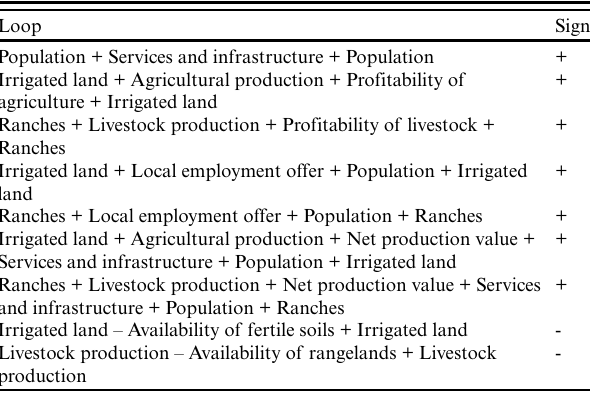
Table 2 . Feedback loops and their